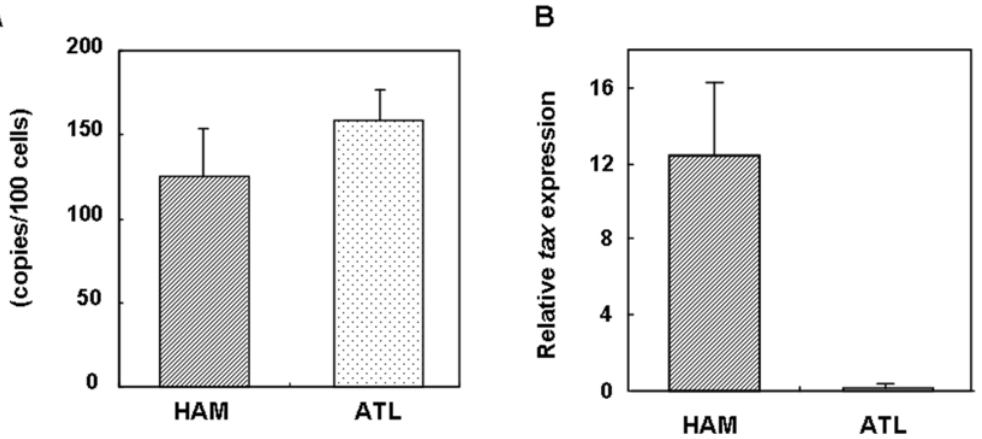
Figure 6. Increased HTLV-1 tax expression in CD4 + CD25 + CCR4 + cells from HAM/TSP patients. HTLV-1 proviral DNA load and HTLV-1 tax expression in CD4 + CD25 + CCR4 + cells from HAM/TSP and ATL patients. The HTLV-1 proviral DNA load was measured in the CD4 + CD25 + CCR4 + cells from HAM/TSP and ATL patients (left panel, n=3), and the HTLV-1 tax mRNA expression (right panel, HAM: n=4, ATL: n=3) was quantitatively measured. Data are presented as mean 6